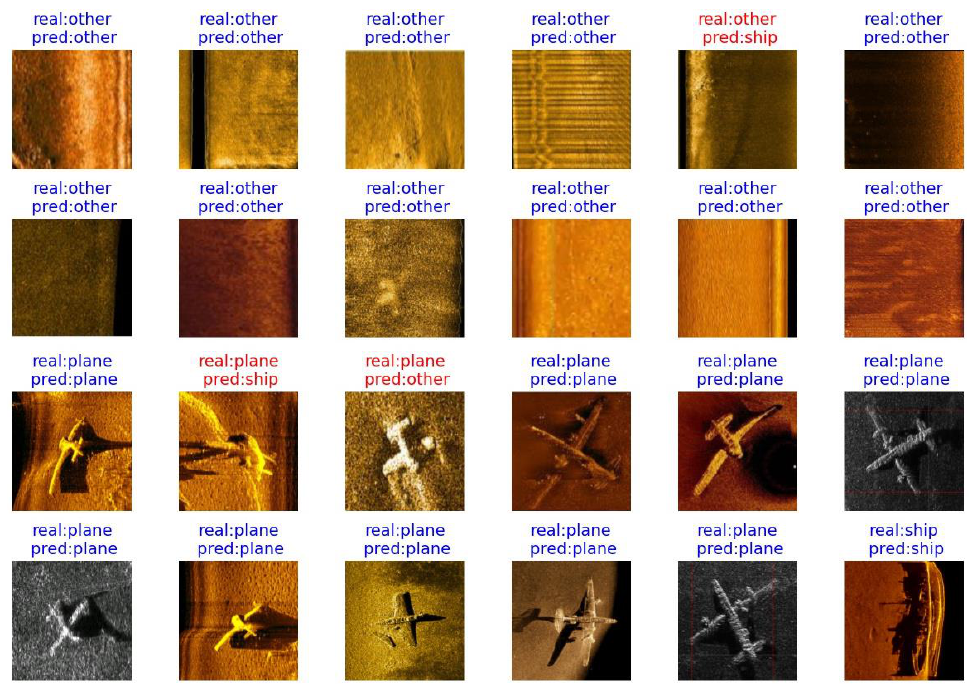
Figure 15. Classification results on part of the validation set by our method. Incorrect classifications are marked in red.